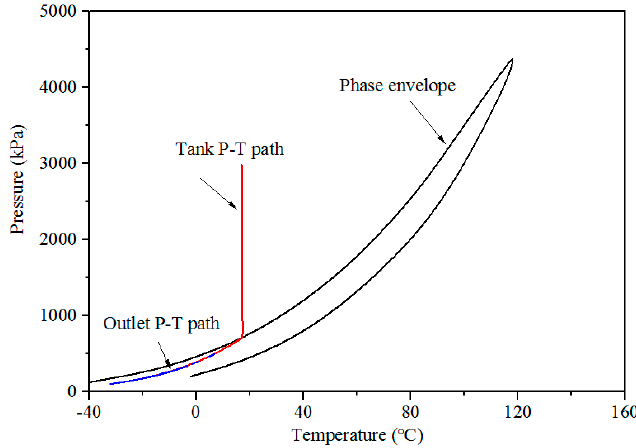
Figure 15. Changes in temperatures in the tank and at the outlet of the leak hole over time.